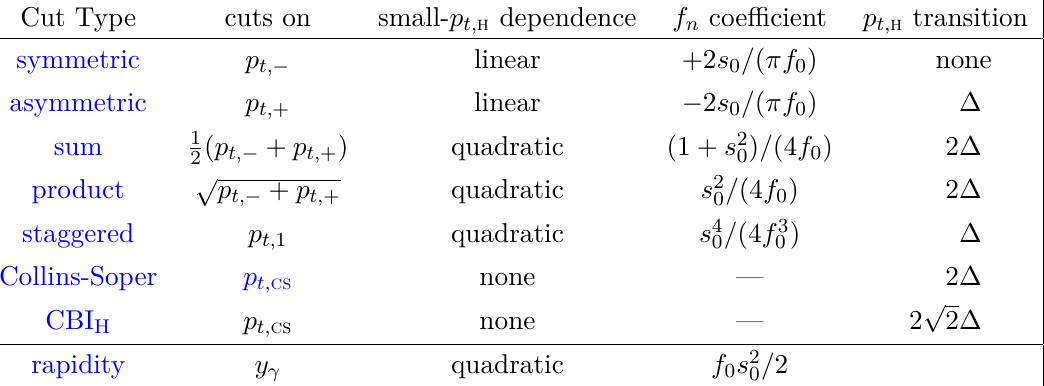
p 1 − s 2 , while 0 (cid:0) (cid:1) ∆ 2 /m h corrections not shown). For the